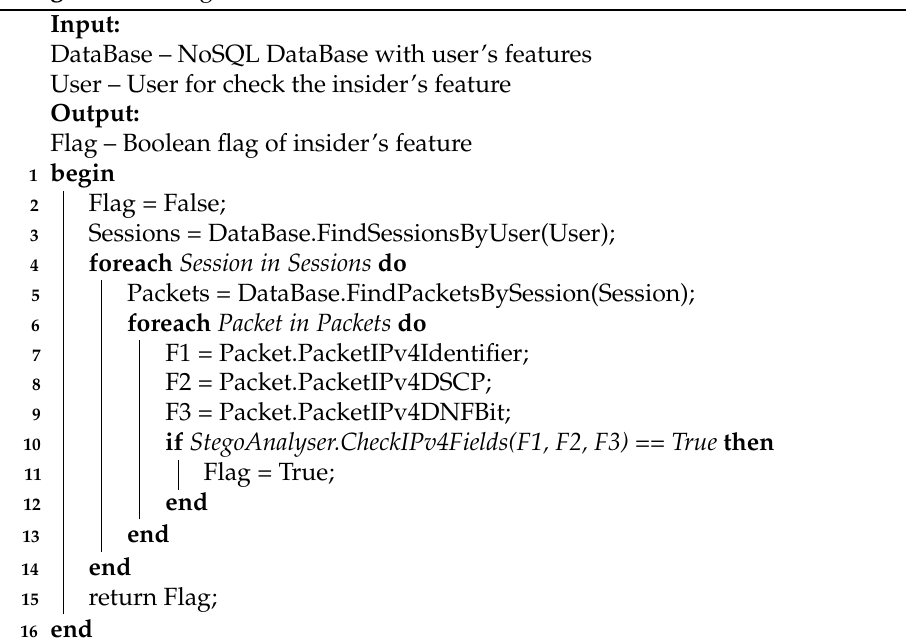
Algorithm 4: Algorithm for Feature